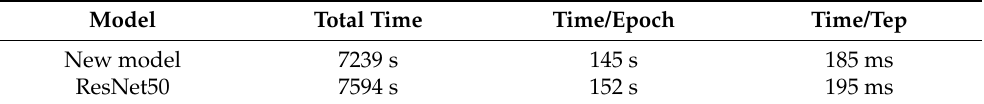
Table 10. Computational cost of the ResNet50 model and proposed model for the CIFAR-10 dataset.